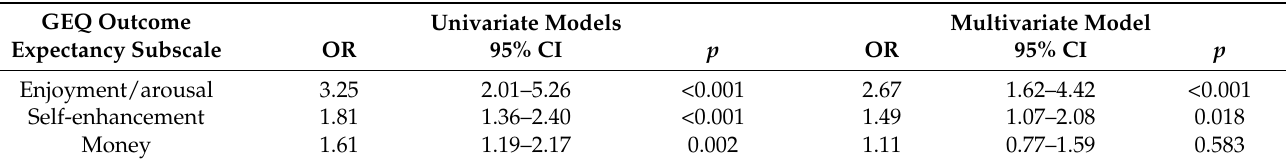
Table 6. Ordinal logistic regression analyses of pre-EMA gambling outcome expectancies predicting PGSI problem gambling severity ( n =